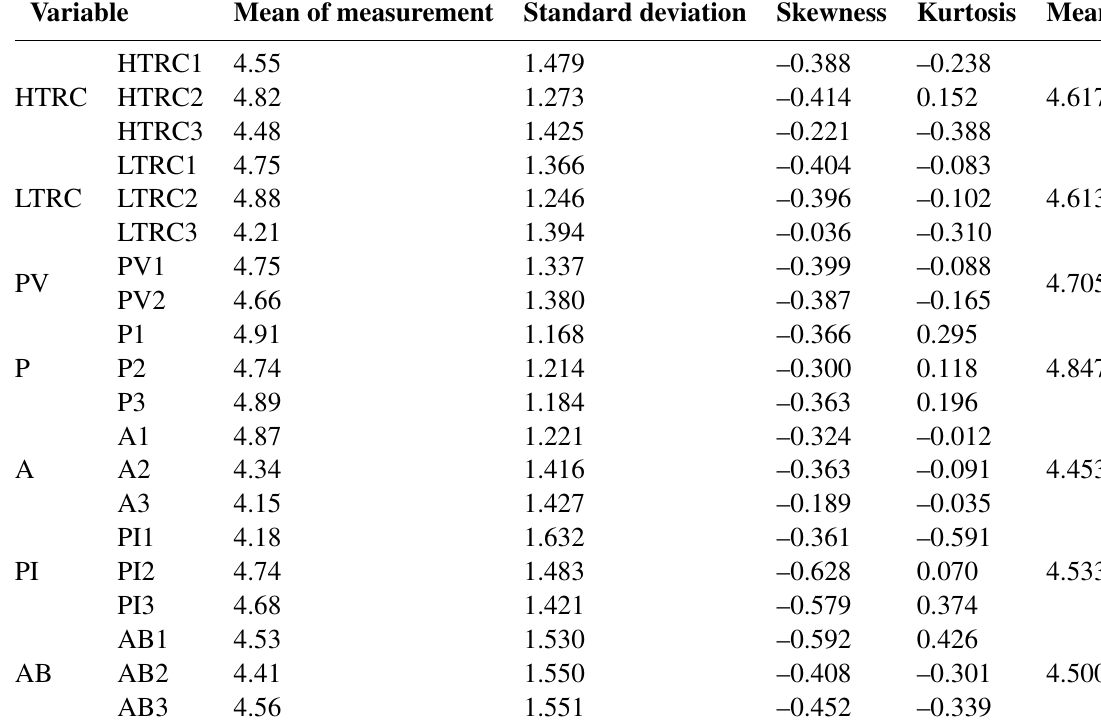
Table 2 Descriptive statistics of each type of item on the questionnaire